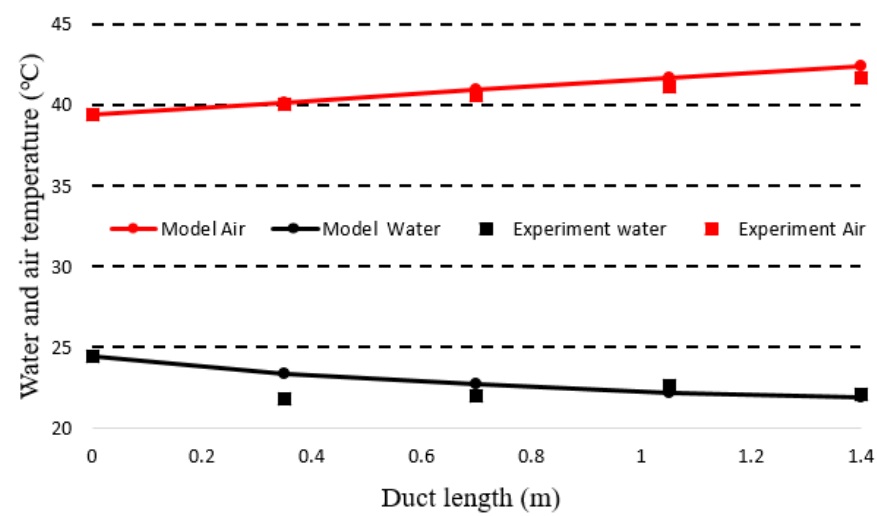
Figure 15. Experimental and simulated air and water temperatures on 22 June at 13:50. The RMS% is 0.78% and 3.4% for air temperature and 1.9% and 1.58% for water tem- perature for Figures 15 and 16, respectively.